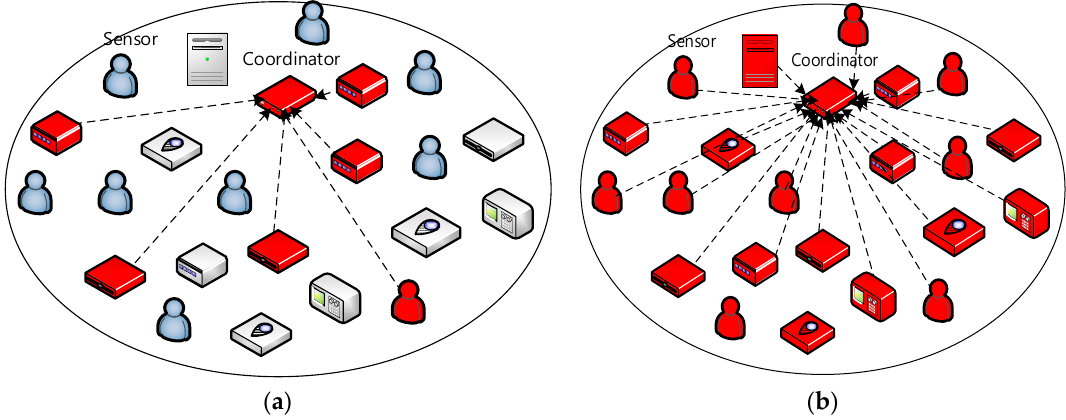
Figure 2. Traffic congestion model: ( a ) off/peak time network; ( b ) peak time network.